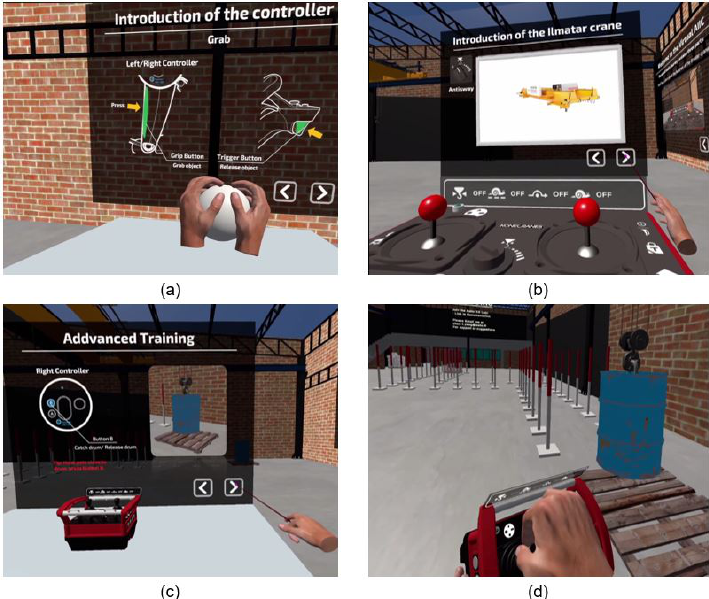
Figure 9. VR training app: ( a ) Be familiar with the fundamental features of the VR environment. ( b ) Interact with the large-scale remote controller to learn the smart features of the crane via the video stream. ( c ) Learn how to interact with the gradable same-scale remote controller. ( d ) Complete the realistic-looking training